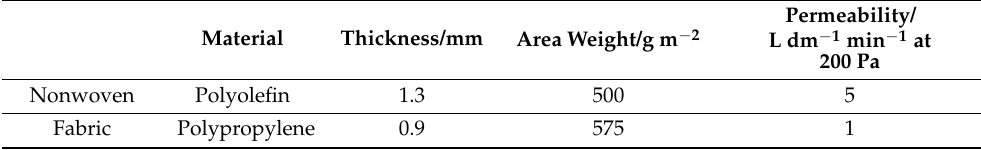
Figure 4. Optical microscope image of nonwoven. ( a ) upstream side ( b ) downstream side